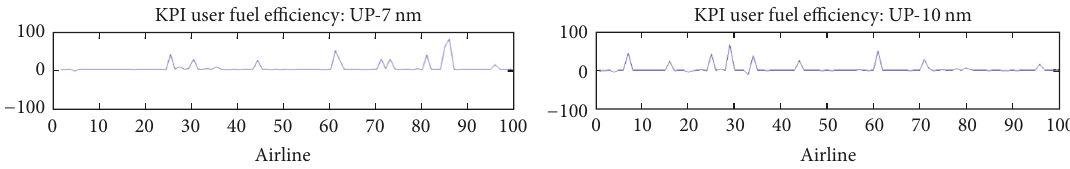
Figure 10: User fuel efficiency (Kg/flight) per airspace user for the analysis cases of 7 NM/100-AUs and 10NM/100-AUs.